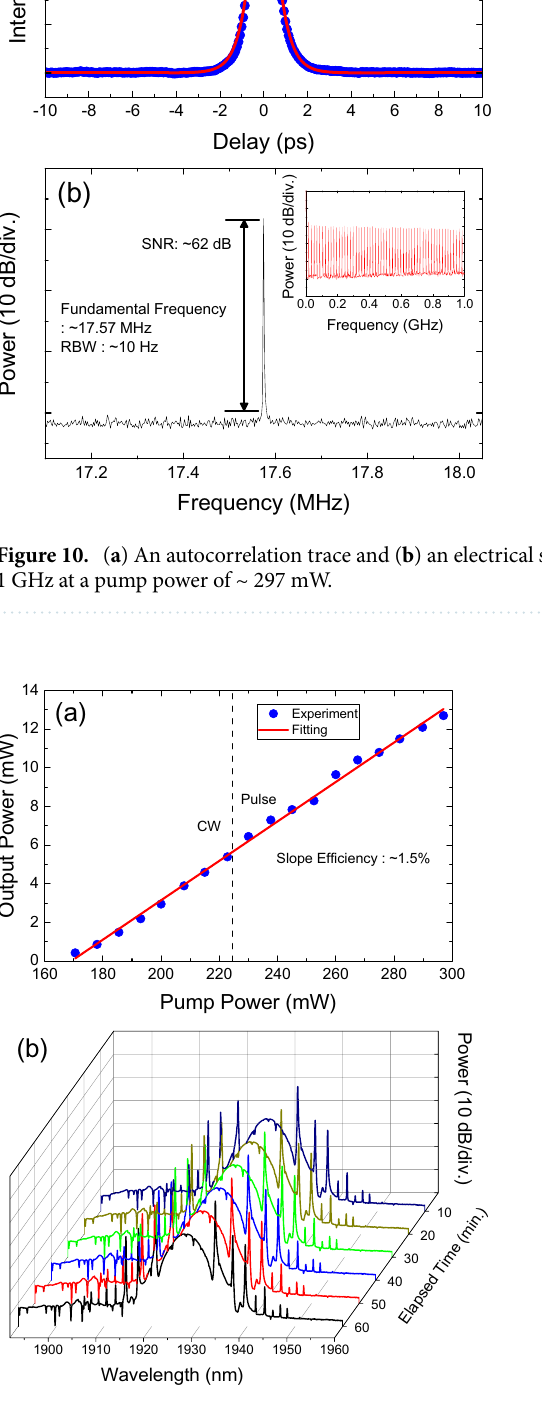
Figure 11. ( a ) Pump output characteristics with continuous wave and pulse regions shown. ( b ) Measured output optical spectrum with a pump power of ~ 297 mW for 1